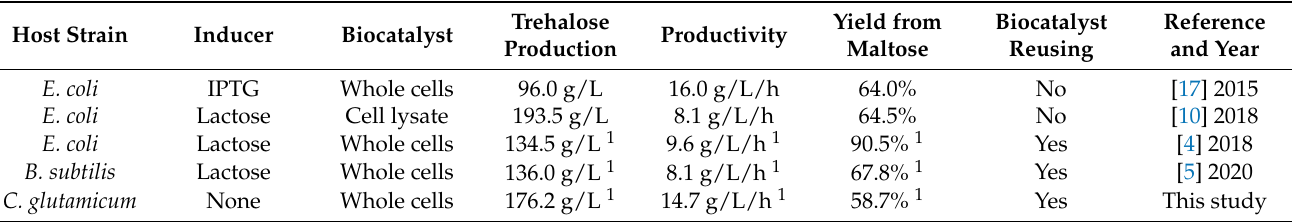
Table 3. Overview of enzymatic trehalose production by TreS pathway in recent